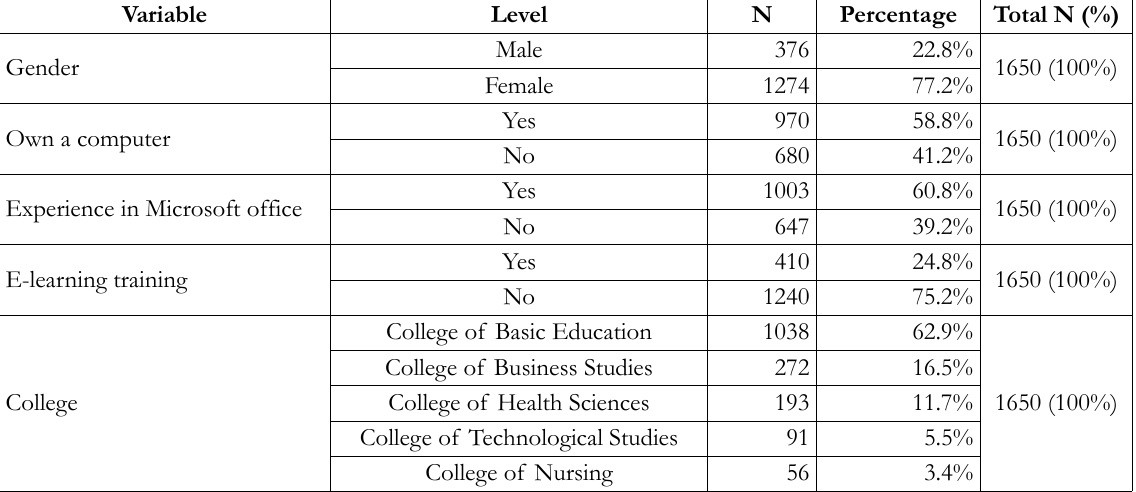
Table 2. The demographic information of the participants